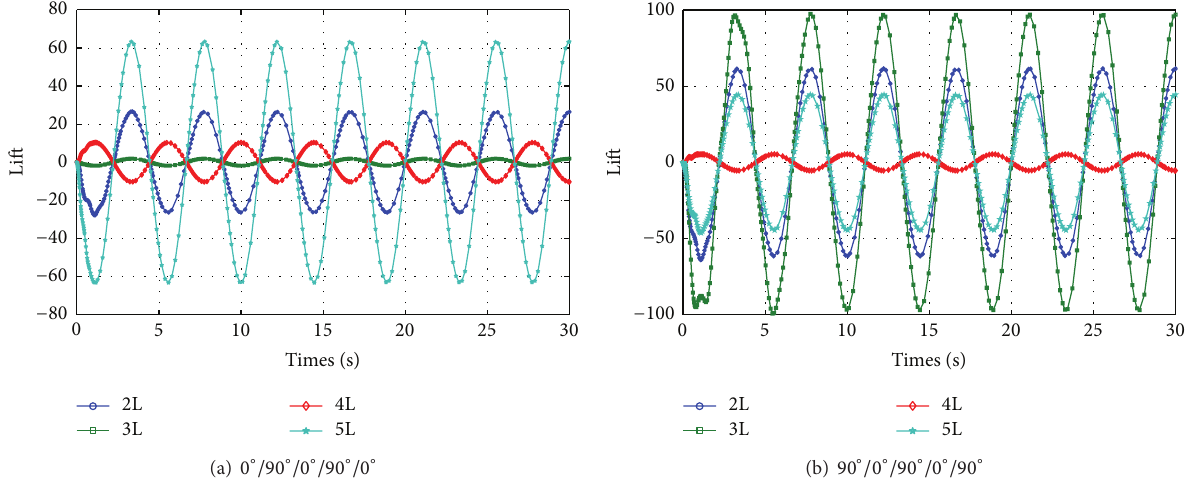
Figure 6: Lift of fin in the case of translation